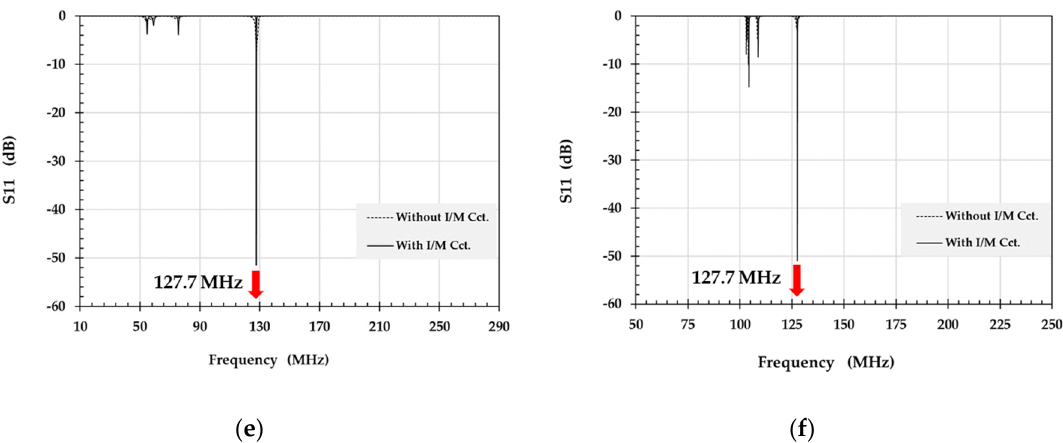
Figure 9. Reflection coefficient S11 for the different configurations of the birdcage RF coil without and with impedance matching circuit: ( a ) 1.5 T low pass, ( b ) 1.5 T high pass, ( c ) 1.5 T band pass, ( d ) 3 T low pass, ( e ) 3 T high pass, ( f ) 3 T band pass.